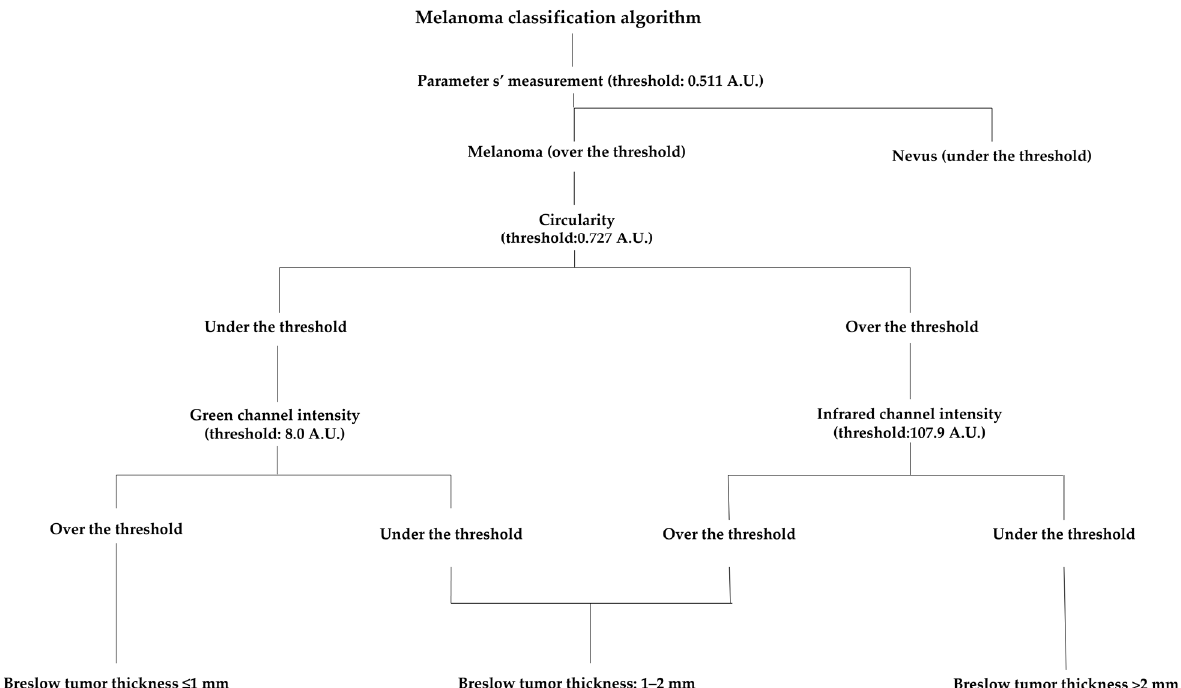
Figure 4. Melanoma classification algorithm. Based on the shape descriptors and intensity values, our melanoma classification algorithm was calculated to classify the multispectral images of melanomas with different Breslow tumor thicknesses. As a first step, this algorithm excludes nevi from the analysis with the use of parameter s’ (threshold: 0.511 A.U.). The second step is a threshold between lower and higher circularities that was established (threshold: 0.727 A.U.), which sorted melanomas into two groups: (1) low and (2) high circularity. The third step was the classification of melanomas from these two subgroups to the three previously defined groups (Breslow tumor thickness ≤ 1 mm, Breslow tumor thickness 1–2 mm, Breslow tumor thickness >2 mm). We used the intensity values of green channel (threshold: 8.0 A.U.) and the infrared channel (threshold: 107.9 A.U.). This algorithm was able to classify melanomas into three subgroups with a sensitivity of 78% and specificity of 89%.